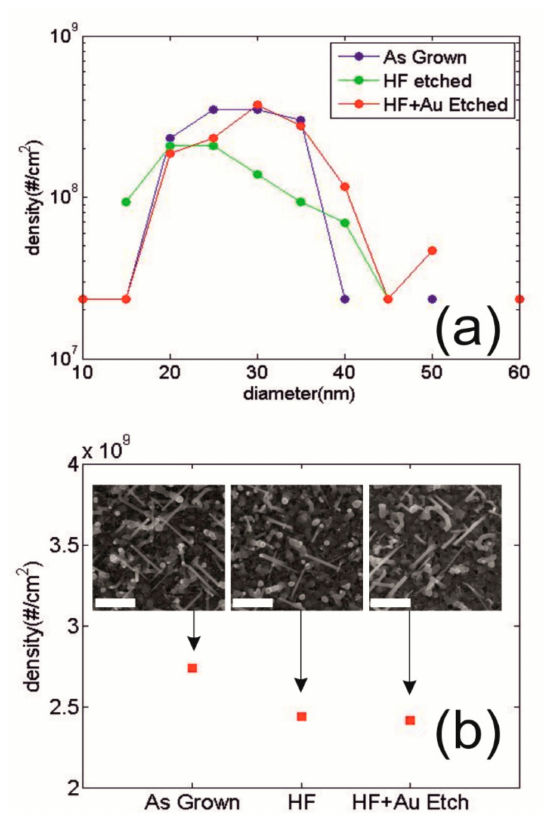
Figure 3. ( a ) Si-NWs density as a function of diameter is reported for as-grown sample (blue circles), after the HF etching (green circles) and after HF + Au etching (red circles). ( b ) Average Si-NWs surface density for the three cases under study. The inset shows the relative SEM micrograph in planar view scale markers corresponds to 400